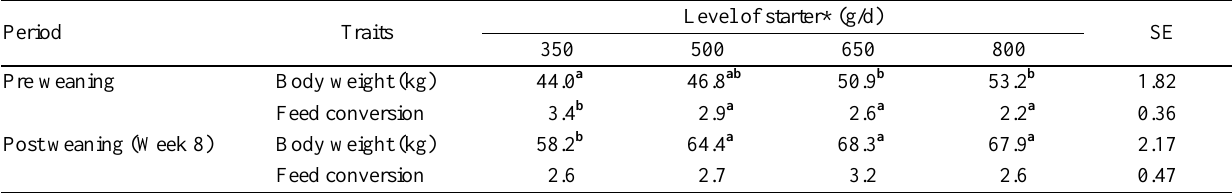
Table 2. Effects of levels of starter on body weight and feed conversion Period